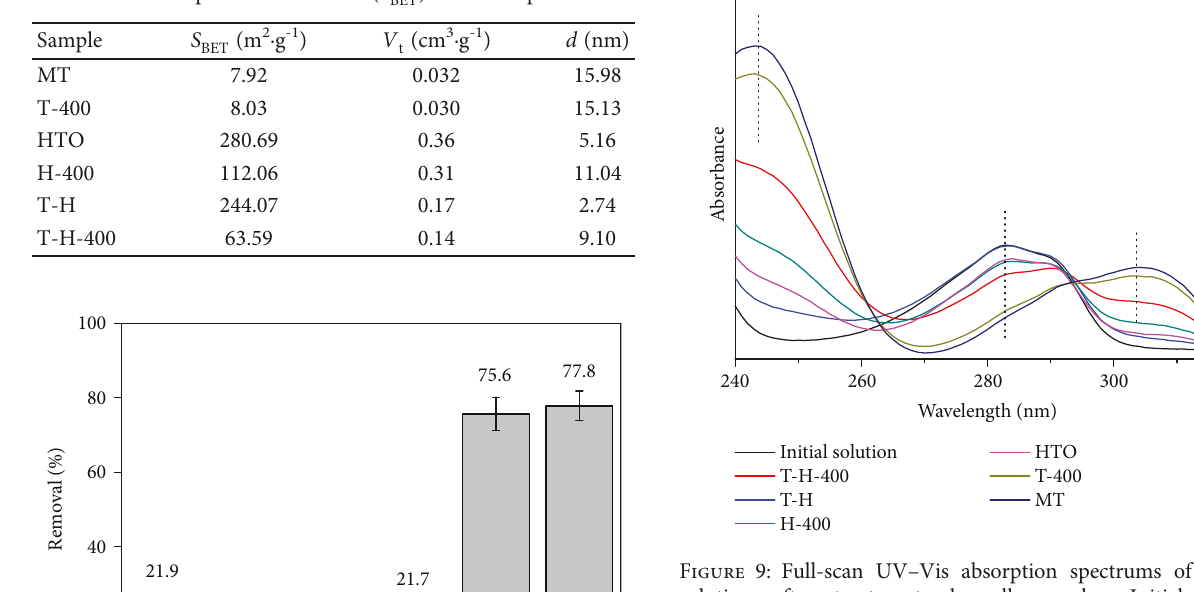
BET ) of the samples.